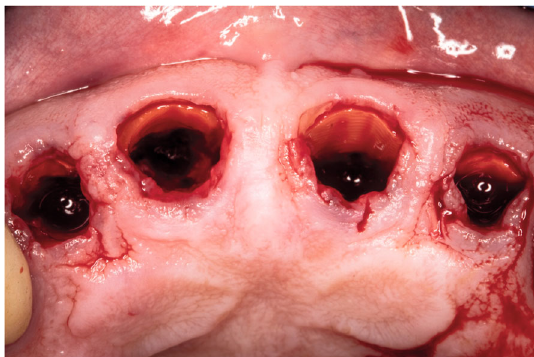
Figure 2: Periapical X-rays of the 4 incisive roots.